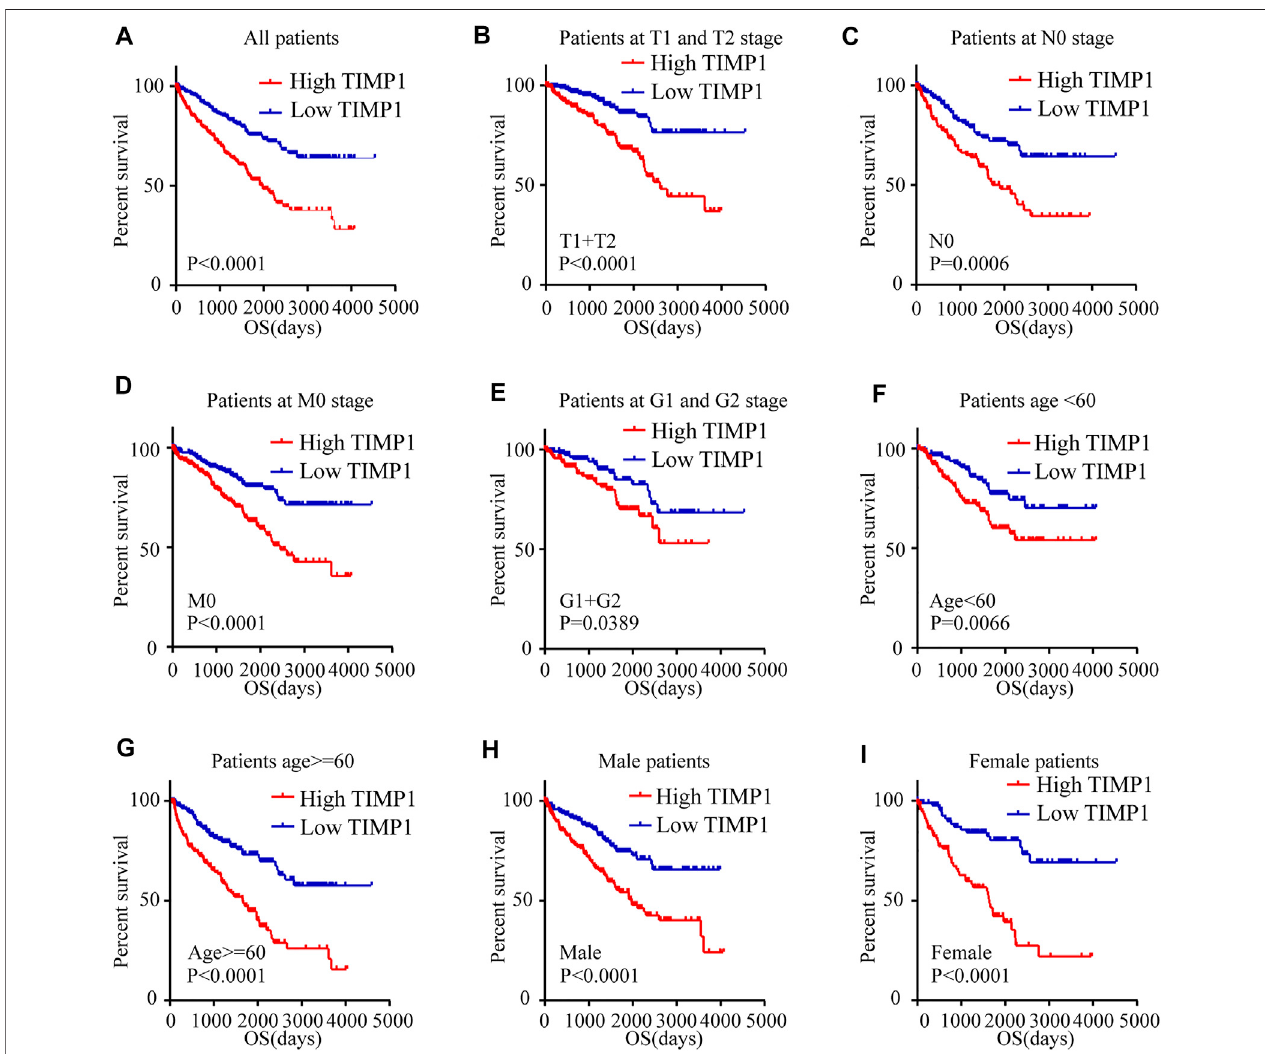
FIGURE 3 | High level of TIMP1 indicated poor OS of patients with RCC. Kaplan-Meier curves for overall survival (OS) were performed in patients with RCC based ontheTCGAdatabase. (A) OSwascloselyassociatedwithTIMP1levels.OSsubanalysiswasappliedinpatientswithdifferentclinicalparameters. (B) PatientsatT1and T2 stage, (C) Patients at N0 stage, (D) Patients at M0 stage, (E) Patients at G1 and G2 stage, (F) Patient with age < 60, (G) Patients with age ≥ 60, (H) Male patients, (I) Female patients. TIMP1, Tissue inhibitor matrix metalloproteinase 1; RCC, renal cell carcinoma; TCGA, The Cancer Genome Atlas.